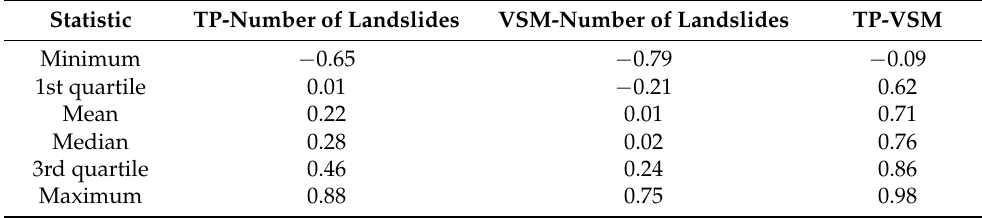
Figure 5. Proportion of landslides that occurred in case that VSM was below the selected percentile threshold. 1st, 2nd and 3rd quartile values for the 136 sub-catchments are shown. Table 3. Pearson correlation coefficients between pairs of variables (i.e., TP, VSM and number of landslides) at the monthly level. Thus, for the 2010–2017 period, average statistics for all months were calculated.